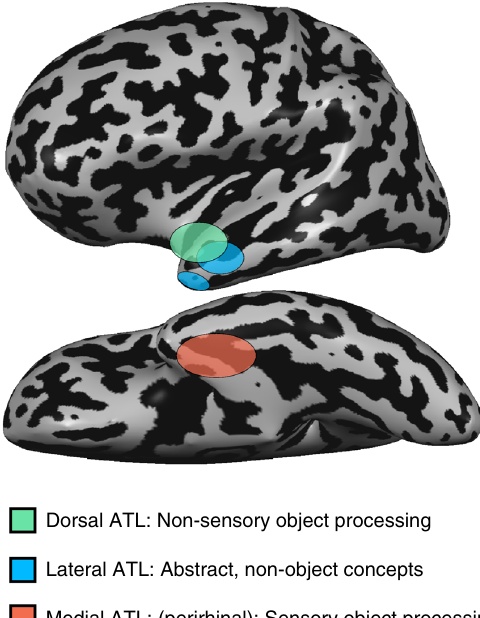
Fig. 7 Summary of ATL division-of-labor. Our results indicate that different aspects of dorsolateral ATL are engaged in the processing of abstract concepts due to a preference for imperceptible concepts (dorsal ATL, marked green) and for reference-free concepts (lateral ATL, marked